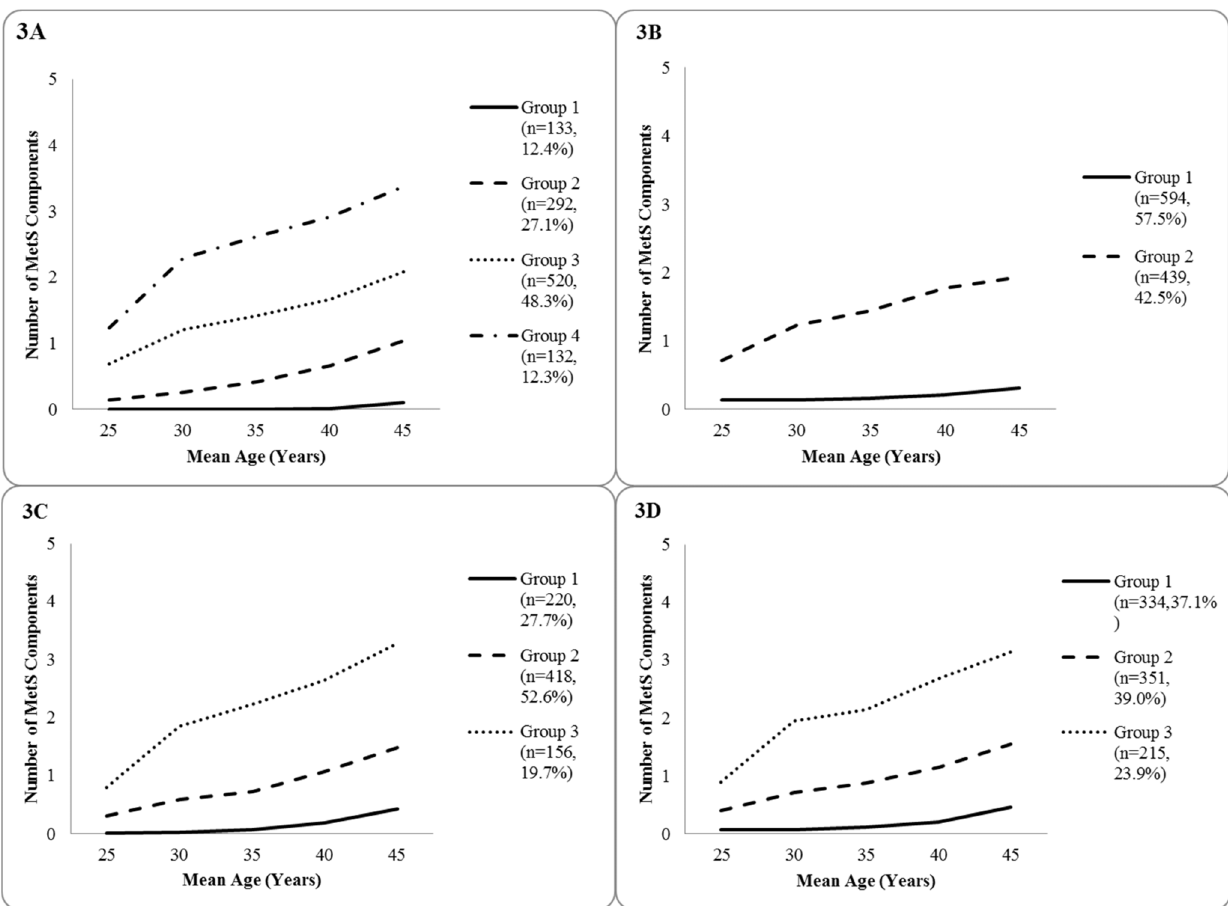
Figure 3. Ethnic-gender specific group-based trajectory of MetS development probability over a 20-year span as determined by PROC TRAJ censored normal modelling in 3 804 apparently healthy young adults. Figure 3A depicts four distinct trajectories among Black females (n=1 077). Figure 3B depicts two distinct trajectories among White females (n=1 033). Figure 3C depicts three distinct trajectories among Black males (n=794). Figure 3D depicts three distinct trajectories among Black males (n=900).